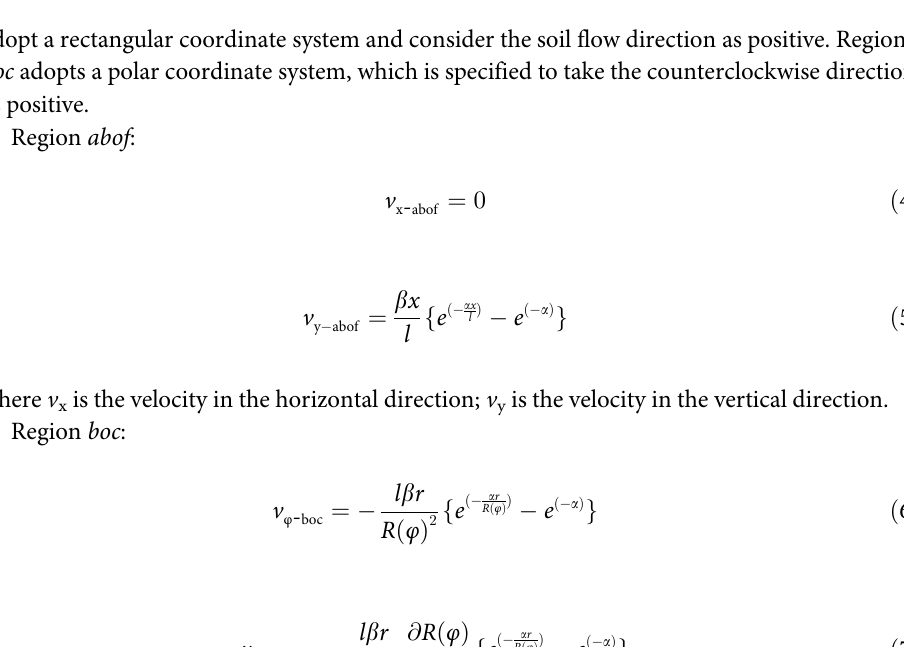
where v is the velocity in velocity in the direction perpendicular to the polar radius direction; φ v r is the velocity in the polar radius direction; r is the distance between a soil element and pole shank o ; R ( φ ) is the polar radius, defined as: